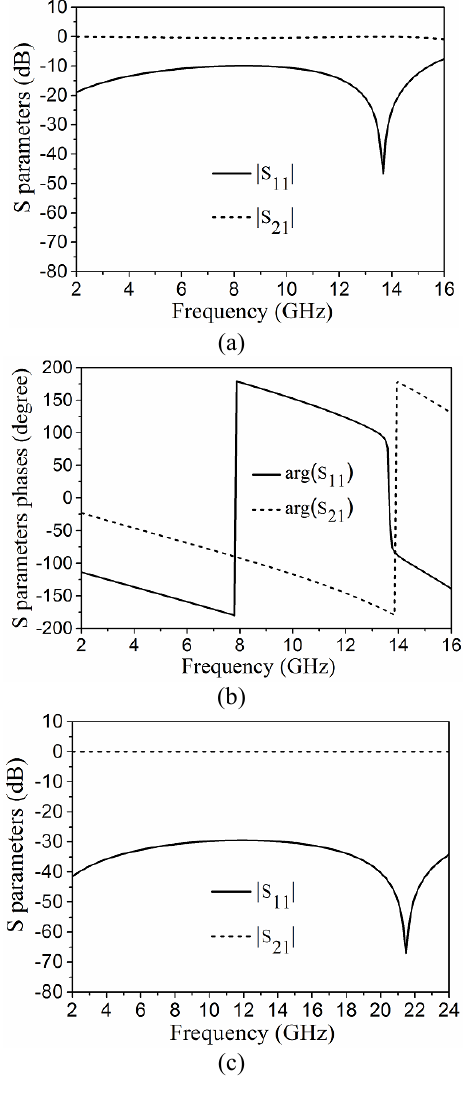
) and permeability ( µ ) for m =4 y z